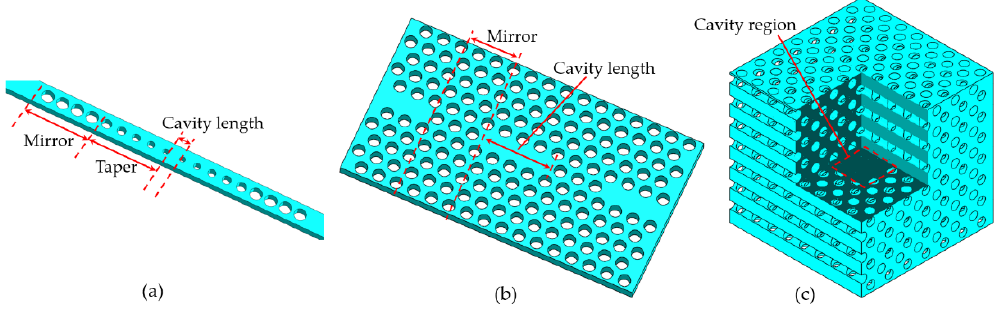
Figure 1. Schematics of ( a ) 1D, ( b ) 2D, and ( c ) 3D photonic crystal (PhC) cavities [37,38].